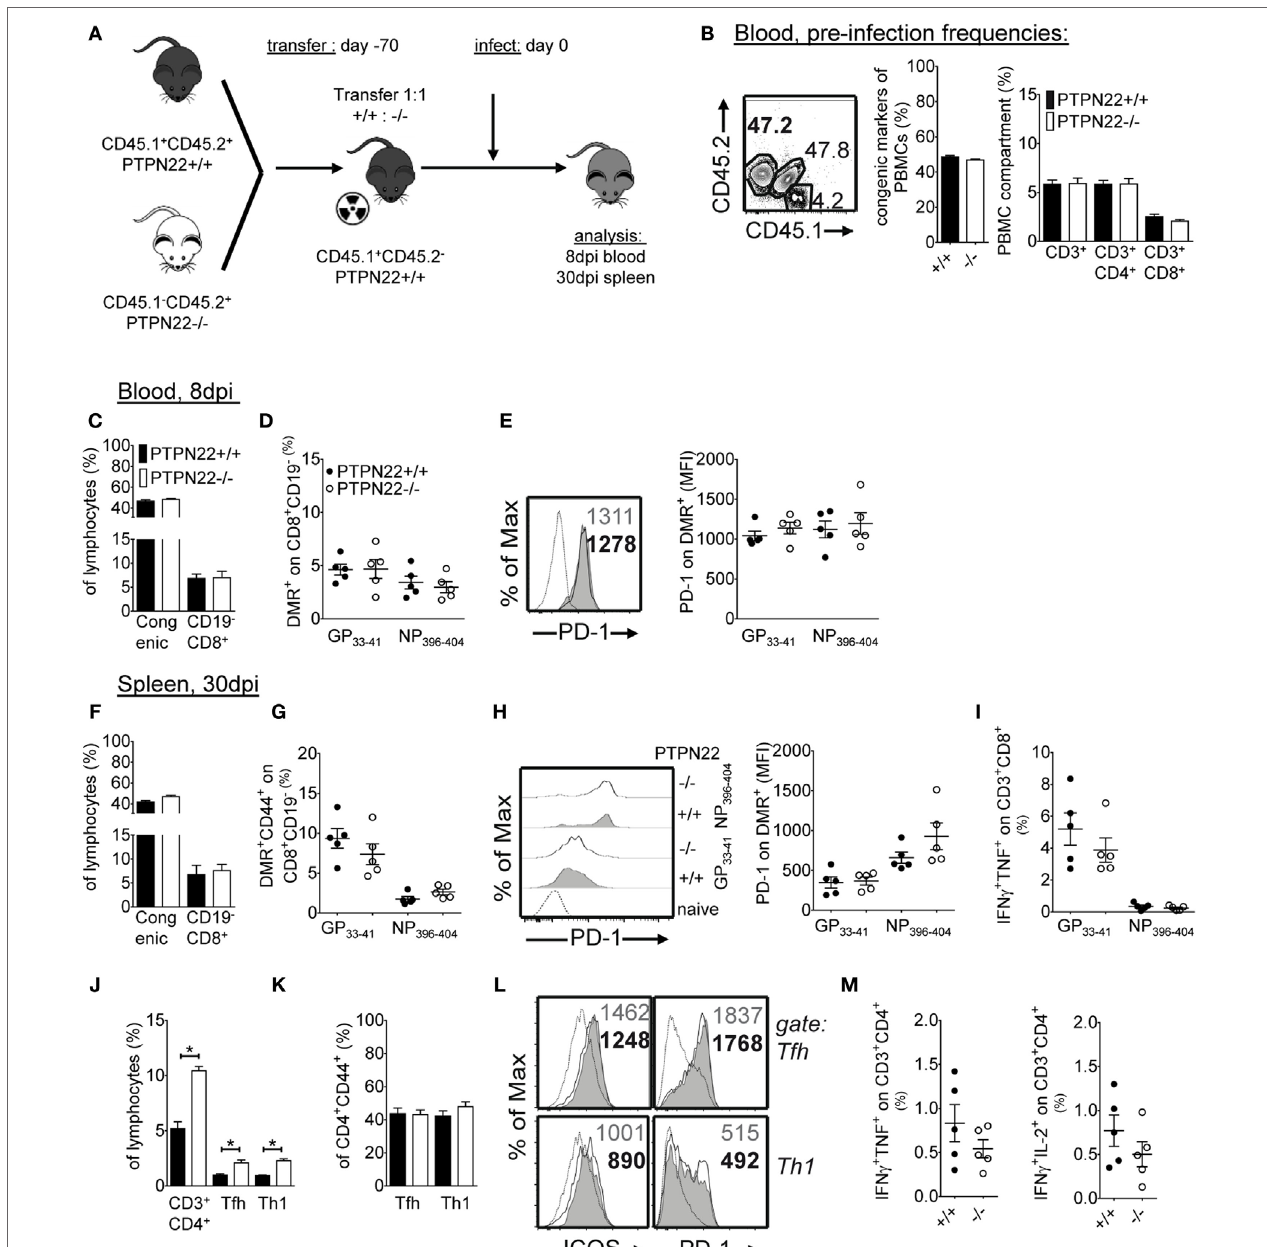
FigUre 7 | The improved CD8 T cell response of protein tyrosine phosphatase non-receptor 22 (PTPN22) deficiency to lymphocytic choriomeningitis virus clone 13 is T cell-extrinsic. (a) Schematic representation of the experimental outline. Lethally irradiated CD45.1 + mice were reconstituted with a 1:1 mixture of CD45.1 + CD45.2 + PTPN22 + / + :CD45.1 − CD45.2 + PTPN22 − / − bone marrow cells. (B) At 60 days after reconstitution, blood was withdrawn to evaluate the proportion of PTPN22 + / + and PTPN22 − / − total, CD3, CD8, and CD4 cells prior to infection. (c,D) Mice were infected as in Figure 1 . The proportions of CD3, CD8, and DMR + cells were determined in the blood 8 days post infection (dpi). (e) Expression levels (geometric mean) of PD-1 were determined on DMR + PTPN22 + / + and PTPN22 − / − CD8 T cells in the blood 8 dpi, with representative histogram overlay for GP 33–41 -specific cytotoxic lymphocytes shown. (F,g) The proportions of CD3, CD8, and DMR + cells were determined in the spleen 30 dpi. (h) PD-1 expression levels (geometric mean) were determined on DMR + PTPN22 + / + and PTPN22 − / − CD8 T cells in the spleen 30 dpi with representative histogram overlay shown. (i) The proportions of IFN- γ /TNF CD8 T cells were evaluated by intracellular cytokine staining following stimulation with GP 33–41 and NP 396–404 peptides [PTPN22 + / + (black circles), PTPN22 − / − (white circles)]. (J) The proportions of PTPN22 + / + and PTPN22 − / − CD4, Th1 (SLAM + CXCR5 − ) and T follicular helper (Tfh) (SLAM lo CXCR5 + ) T cells were determined 30 dpi in the spleen. (K) Frequencies of Th1 and Tfh PTPN22 + / + and PTPN22 − / − cells gated on CD4 + CD44 + are shown. (l) Representative ICOS and PD-1 expression levels on PTPN22 + / + and PTPN22 − / − Th1 and Tfh cells are shown. (M) Splenocytes from chimeric mice were stimulated with GP 61–80 peptide and stained for the indicated cytokines. Coproduction of IFN- γ /TNF and IFN- γ /IL-2 was evaluated [PTPN22 + / + (black circles), PTPN22 − / − (white circles)]. Data are representative of two independent mixed bone marrow chimera experiments. Number of symbols reflects number of mice per group.